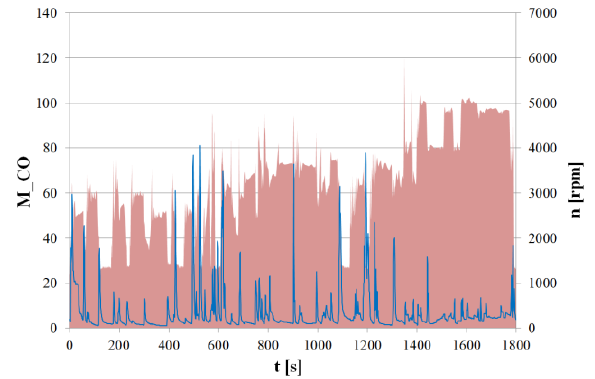
Fig. 7. The course of the engine torque and the M index for CO recorded during the tests in the WMTC test